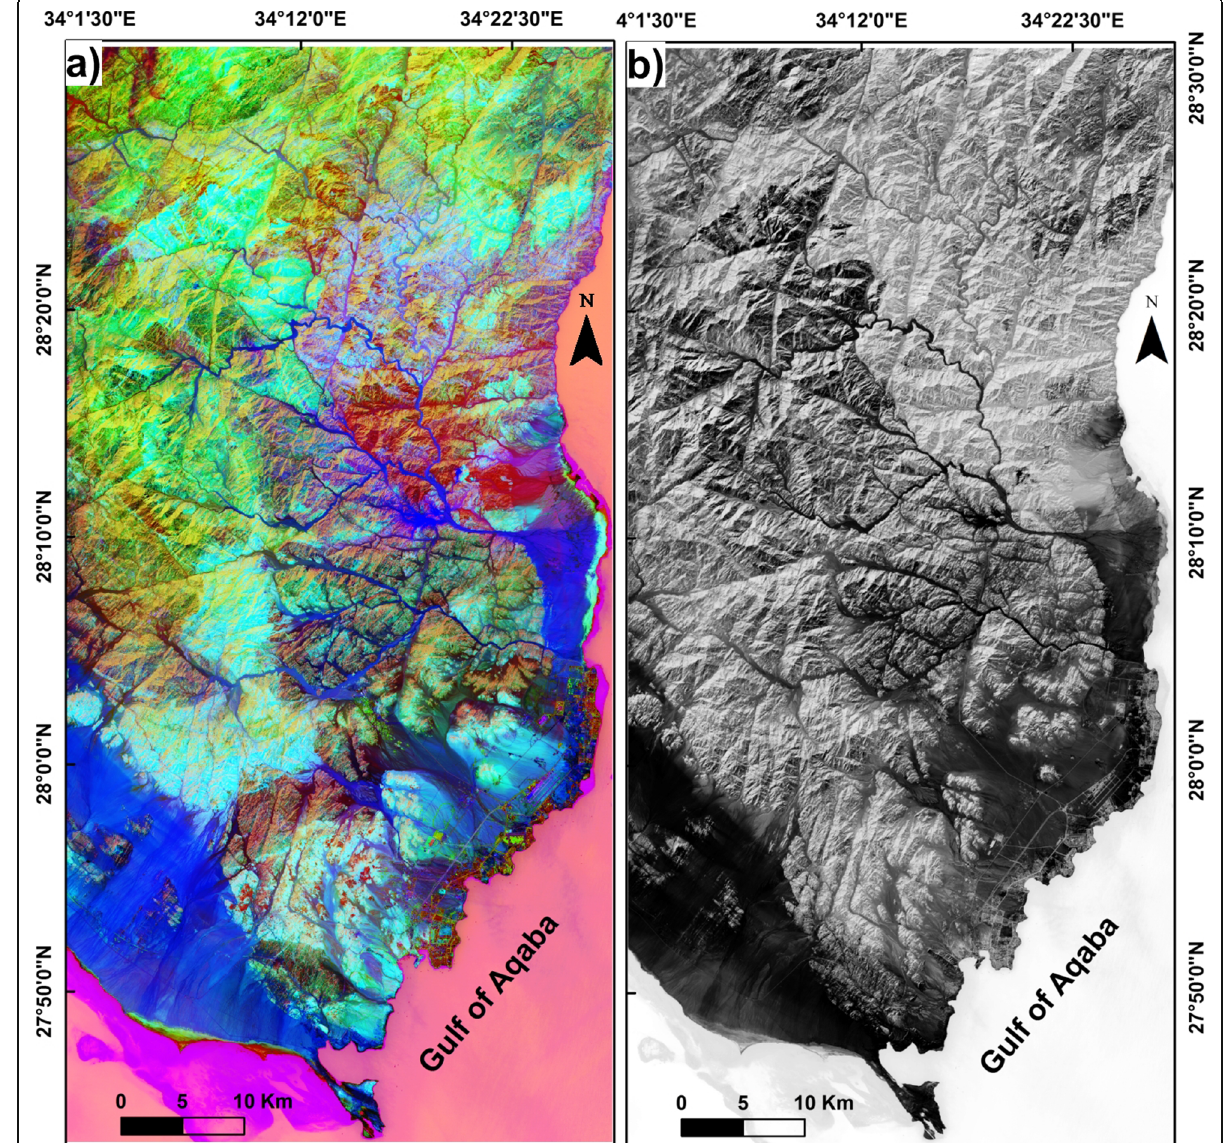
Fig. 6 a Principal component analyses image (PCA) of Landsat 8 (RGB, 123) showing the alluvial fan deposits characterized by dark blue color while the drainage network paths can be distinguished by light blue color. b PCA of a single band (band 1) where all alluvial sediments and fans are appearing with dark black